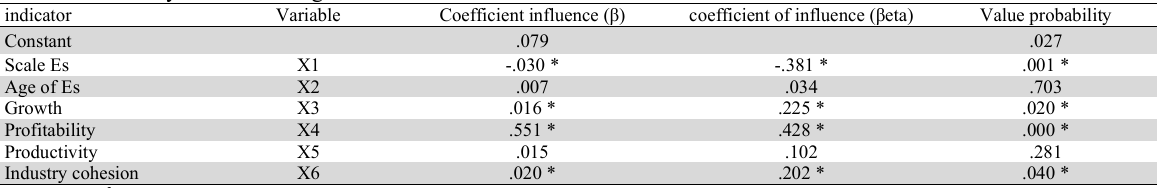
The results of analysis of linear regression model